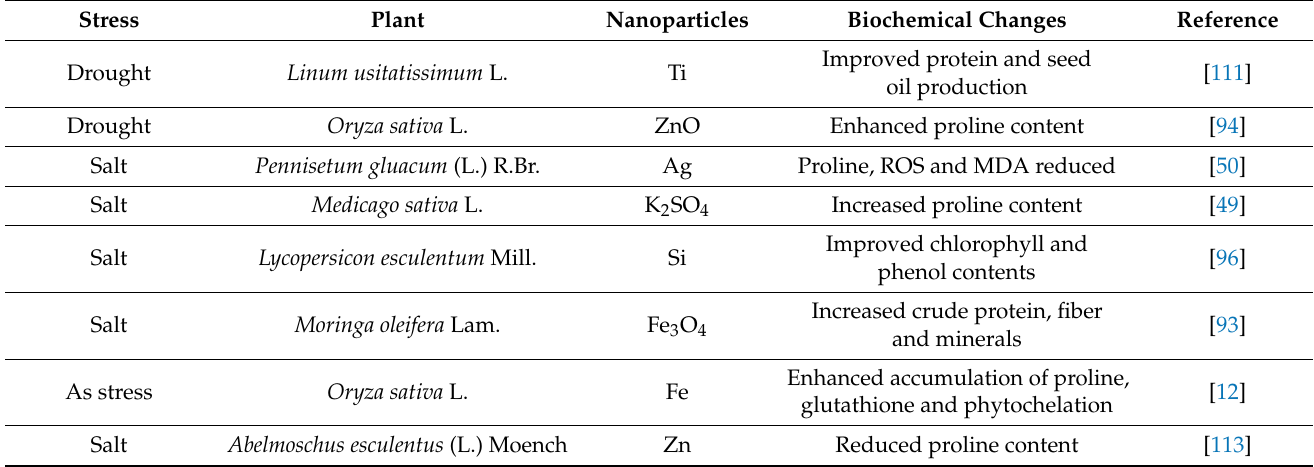
Table 3. Biochemical changes under the influence of